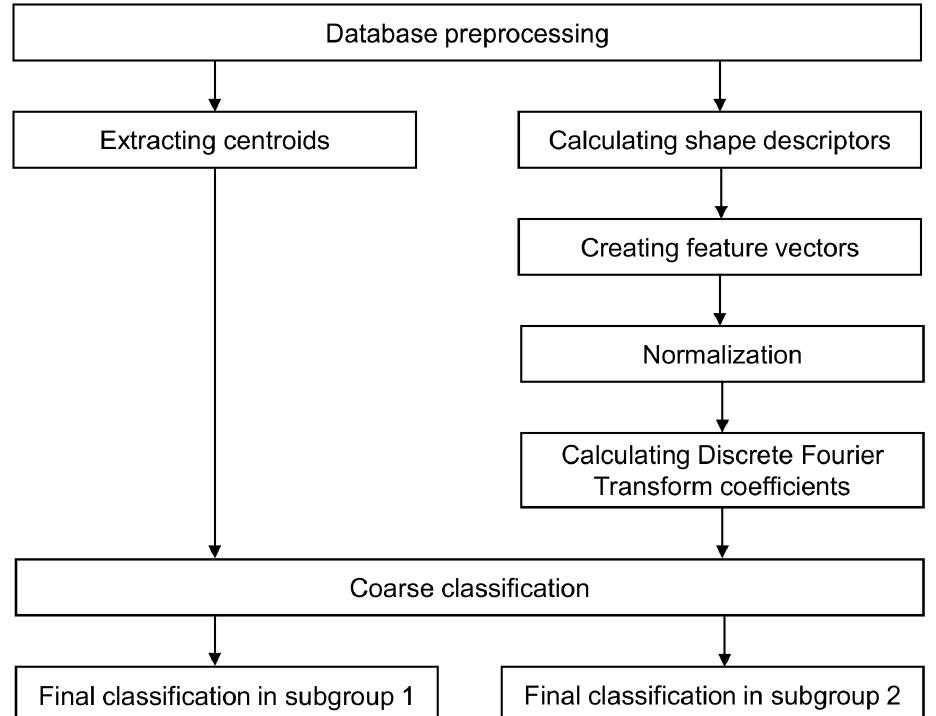
Figure 1. A block diagram representing subsequent steps of the proposed